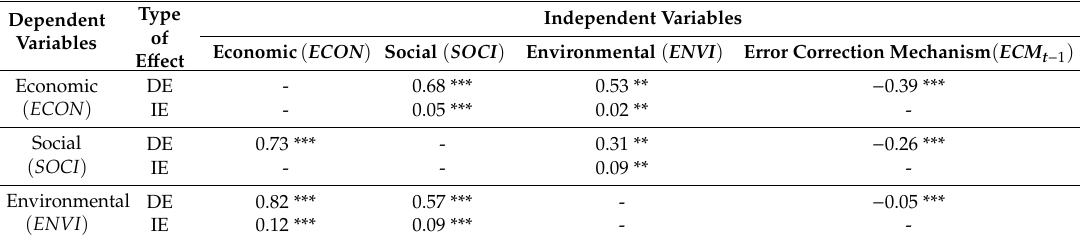
Figure 2. The casual relationship in the SEM-VARIMAX model. Table 3. Results of the relationship of size analysis of the structural equation modeling/vector autoregressive model with exogenous variables (SEM-VARIMAX)